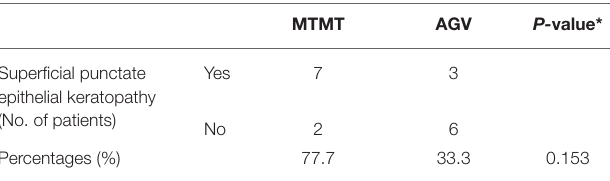
MTMT AGV P- value*